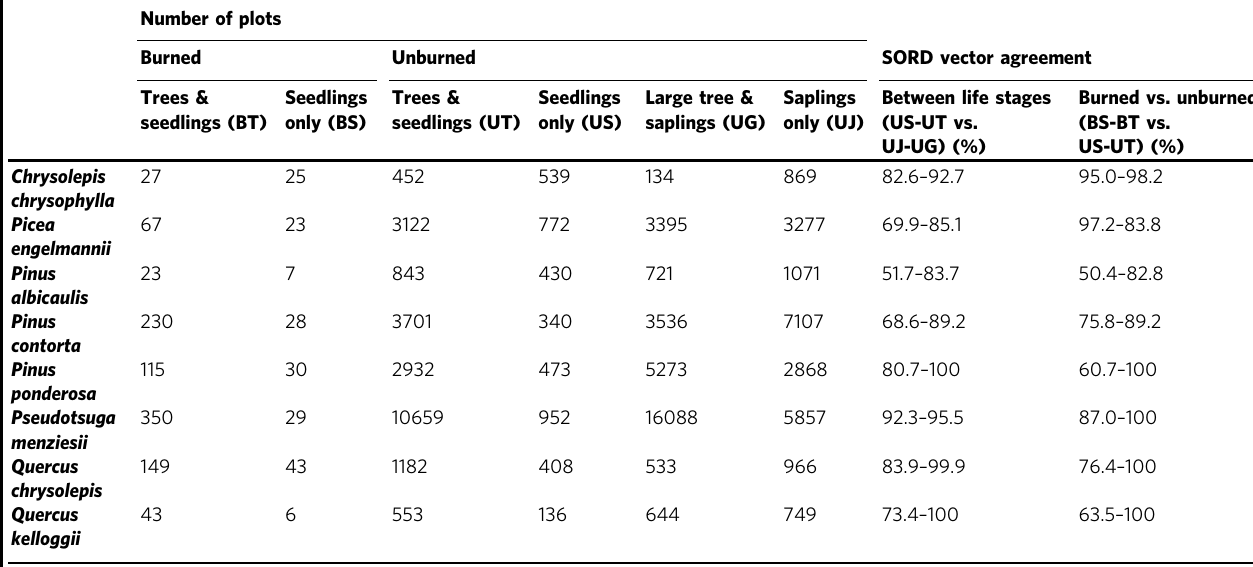
Table 1 Summary of the sample sizes and SORD vector agreement values that were used to determine the species included in further analysis.